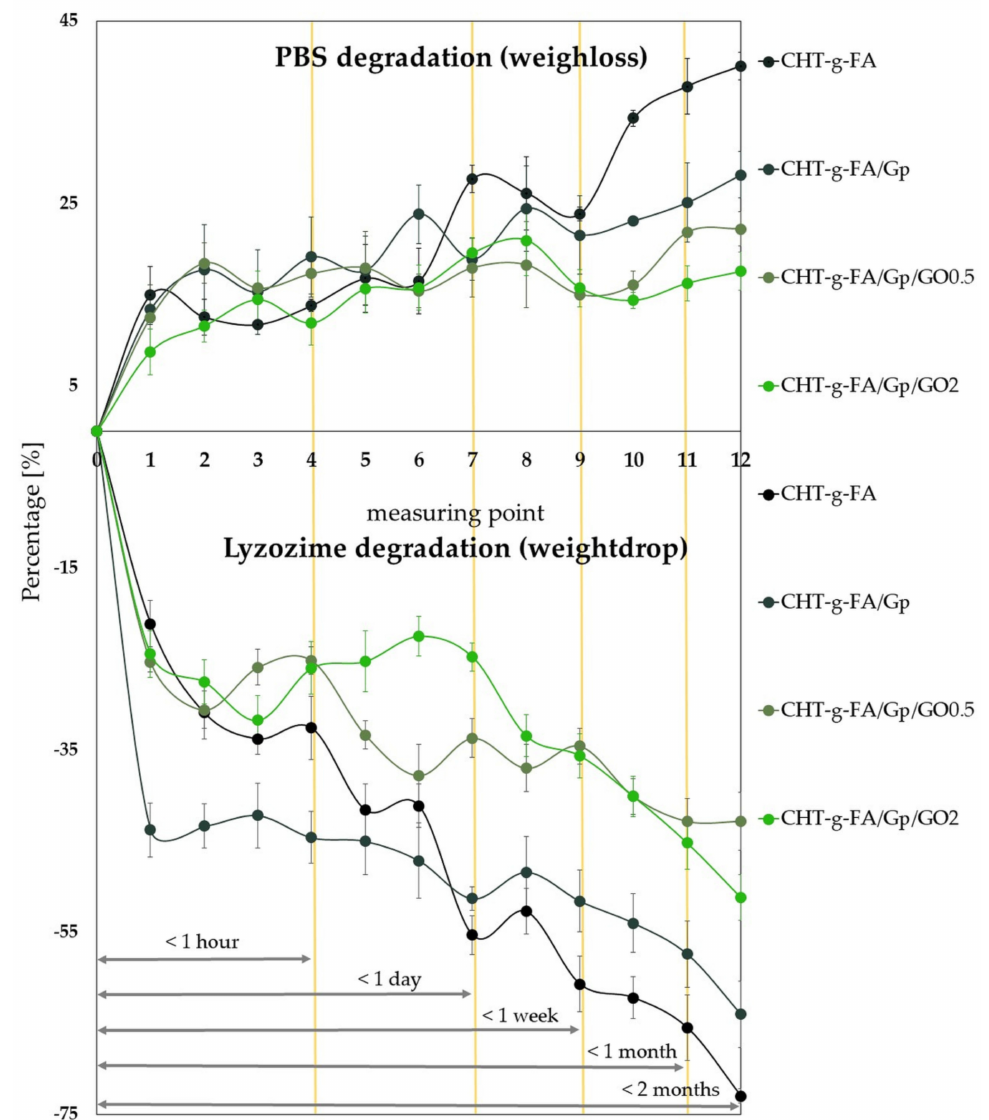
Figure 6. Fused depiction of the specimen weight loss after degradation in PBS and in specialized enzyme rich environment, as a function of temporal milestones (minutes, hours, days, months). For better visualization, one profile was outlined in positive values lost after incubation, while the other one was outlined in negative